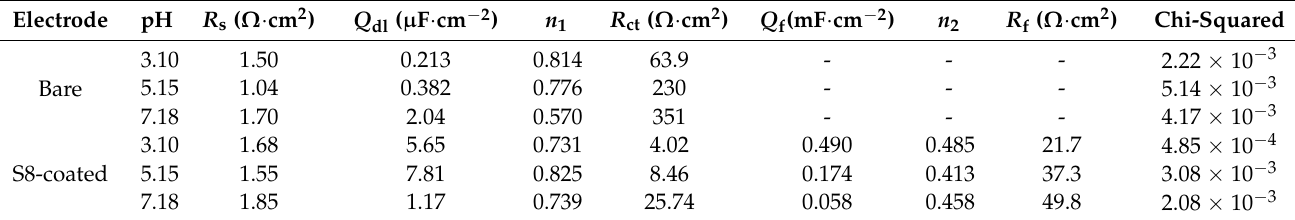
Table 2. EIS data fitted electrochemical